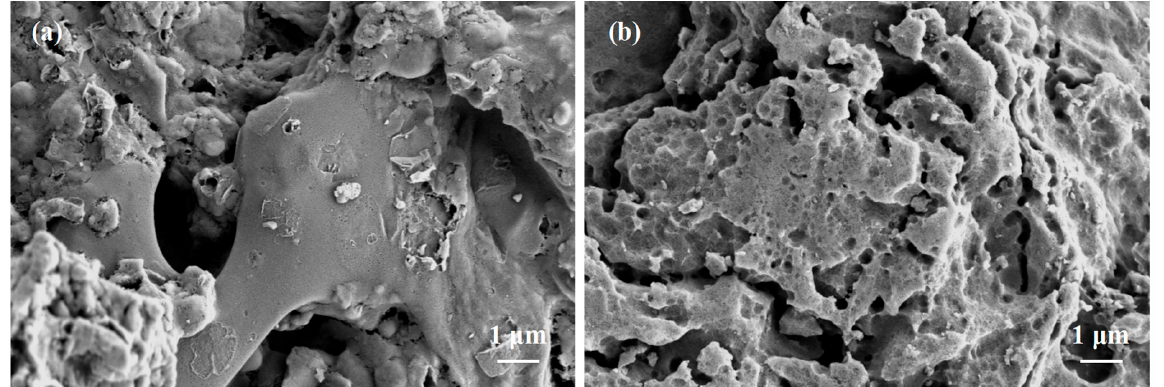
Figure 1. Scanning electron microscope of ARB ( a ) and M-ARB ( b ).